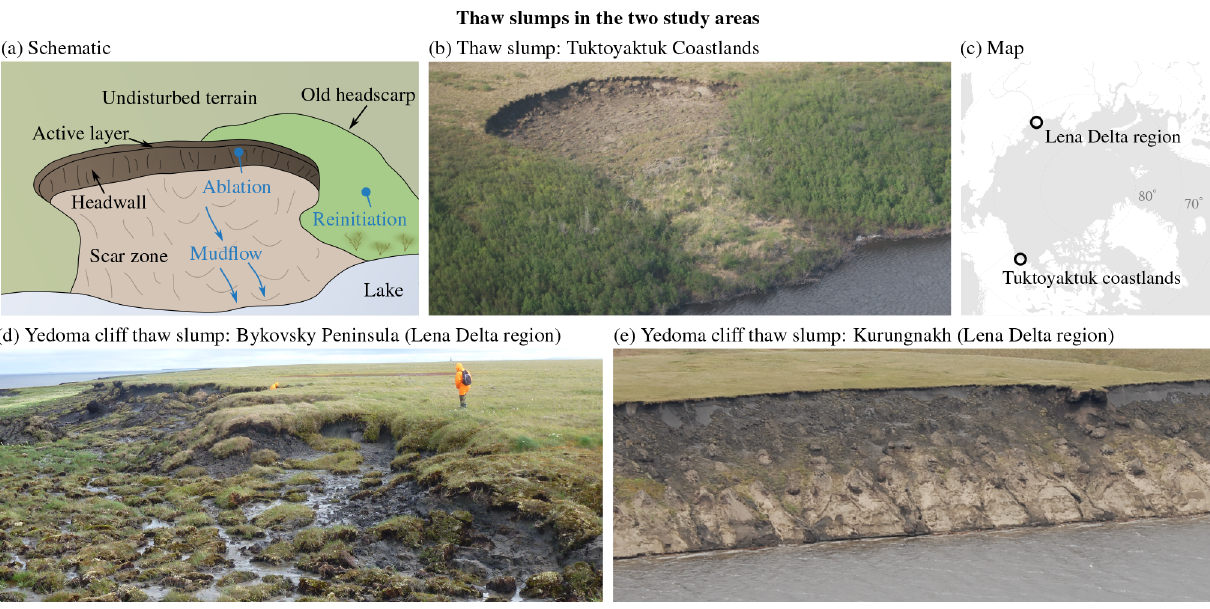
Figure 1. (a) Schematic of a thaw slump labelling features in black and processes in blue. (b) Retrogressive thaw slump in the Tuktoyaktuk coastlands surrounded by relict, now densely vegetated scars on either side (photo by S. Zwieback). (c) Map of the study regions. (d) Head- scarp of an elongated cliff thaw slump along Bykovsky’s coast (photo by G. Grosse). (e) Thaw slump along the east coast of Kurungnakh (photo by J. Boike). Note the clearly visible ice-poor sand unit in the lower half of the approximately 30m high exposure down to the river